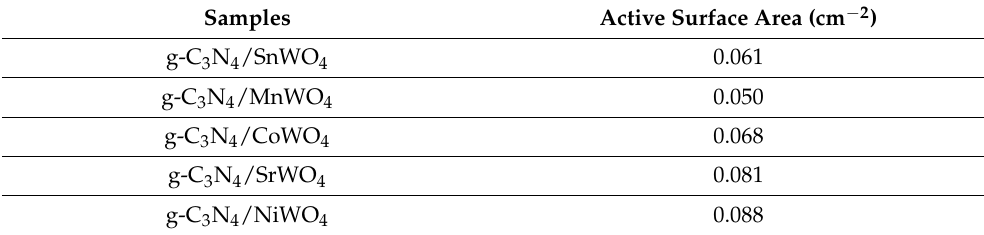
Table 2. Active surface area calculated for modified electrodes.